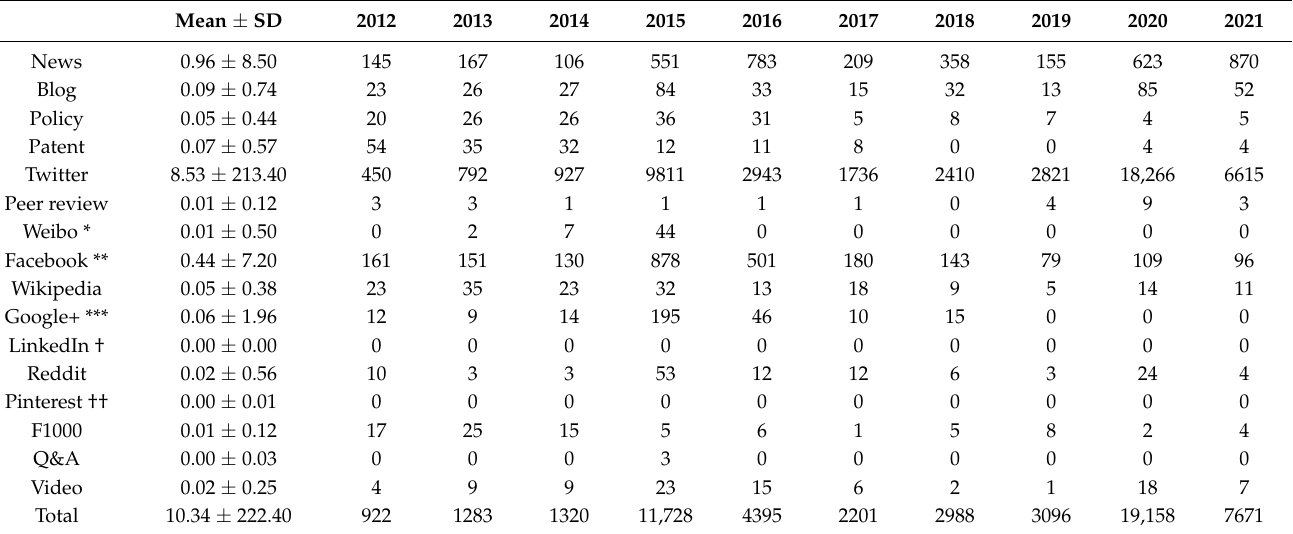
Table 2. Mean and standard deviation of mentions by source and the total number of mentions that Altmetric Explorer has tracked for myopia according to